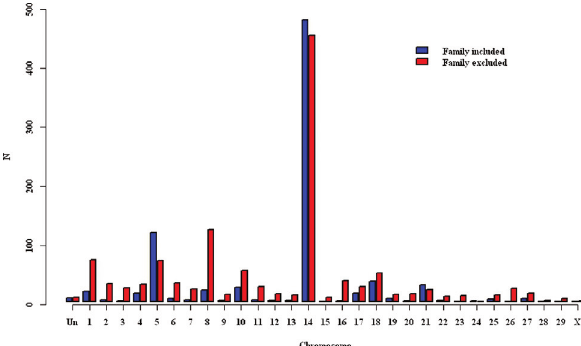
Figure 1 - Number of detected SNP loci associated with birth weight by chromosome from analyses without modeled relatedness with and without the fixed effect of family (“Un” represents SNP that were not assigned to any